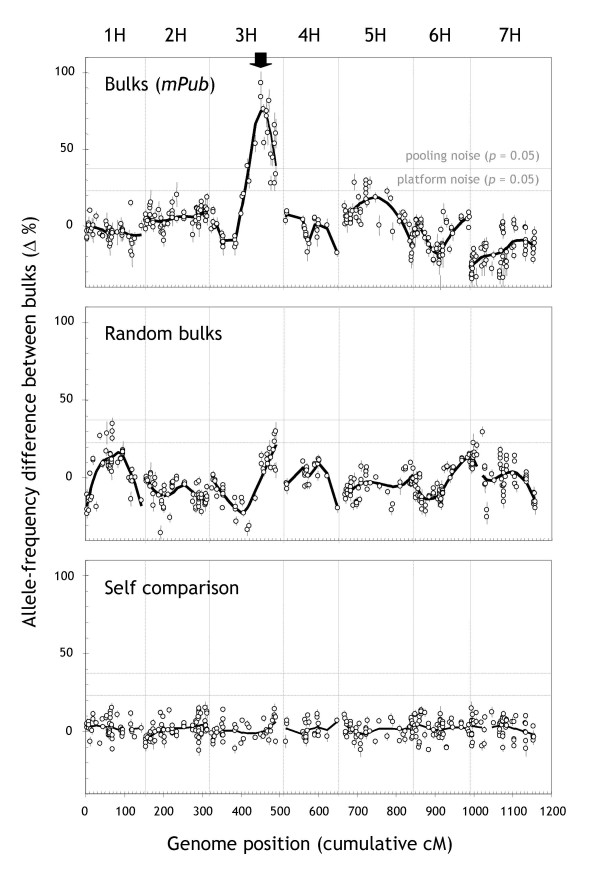
DArT-BSA genome scan for the 'pubescent leaves' (mPub) locus in the Steptoe/Morex DH population. The difference in the frequency of Steptoe alleles between different pairs of DNA pools is shown as a function of the cM positions of markers previously incorporated into a DArT consensus map for barley (375 of 418 polymorphic markers) [20]. The 'Bulks (mPub)' panel displays data from the comparison between bulks contrasting for the mPub locus on chromosome 3H (40 plants each). The black arrow indicates the position of the mPub locus on the DArT consensus map [20] according to which the DH plants had been distributed into bulks. The 'Random bulks' panel displays data from a comparison of two randomly assorted bulks of 40 plants each. The 'Self comparison' panel shows the result of a comparison of two identical aliquots of a 1:1 mixture of Steptoe and Morex. Vertical lines within each of the panels denote borders between individual chromosomes. Horizontal lines indicate two types of significance thresholds. The 'pooling noise' significance threshold was based on a simulation of the bulking process (see Figure 2). The 'platform noise' significance threshold was derived from an analysis of the distribution of values in the self comparison (bottom panel) and Bonferroni-adjusted for multiple comparisons (see section entitled 'Polymorphic marker identification' in Materials and Methods).